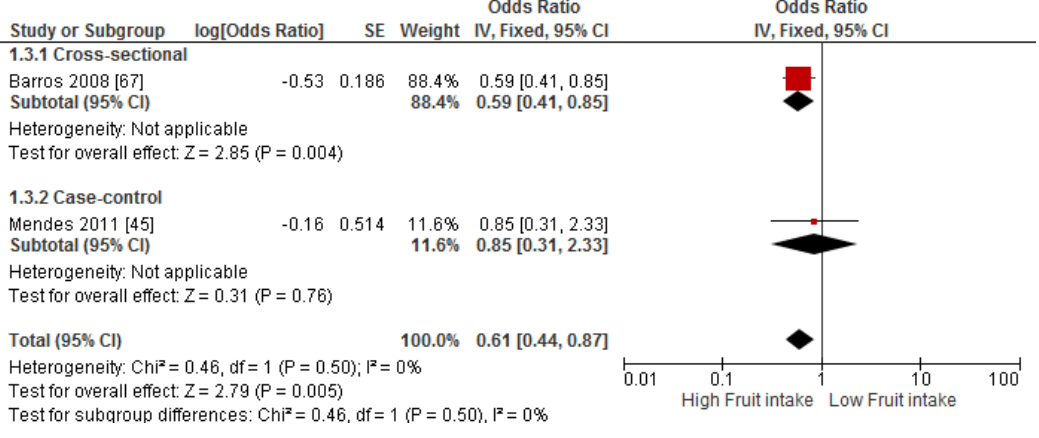
Figure 5. Meta ‐ analysis of the association between vegetable intake and risk of prevalent asthma.